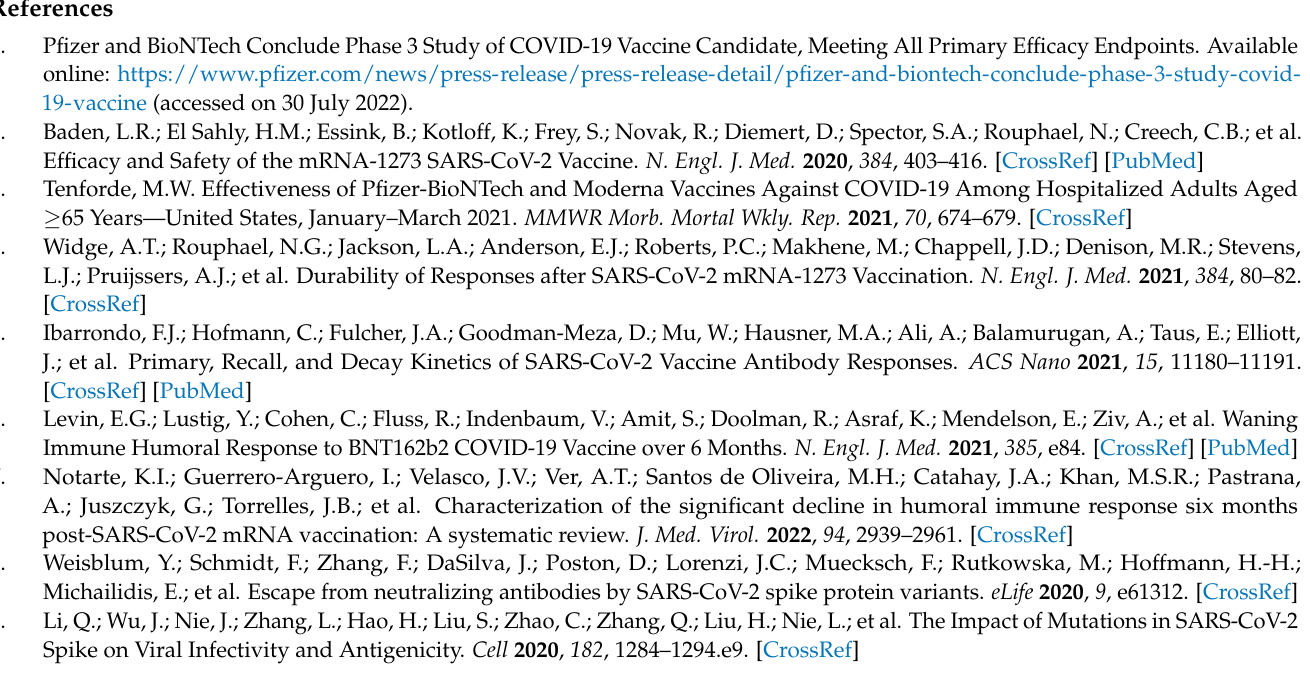
tervals; Table S1: Parameter values for fitted IgG kinetics model with standard errors (SE) and relative standard error (RSE); Table S2: AIC values for prospective model structures; Table S3: Comparison of model-predicted vaccine efficacy over time compared with clinical